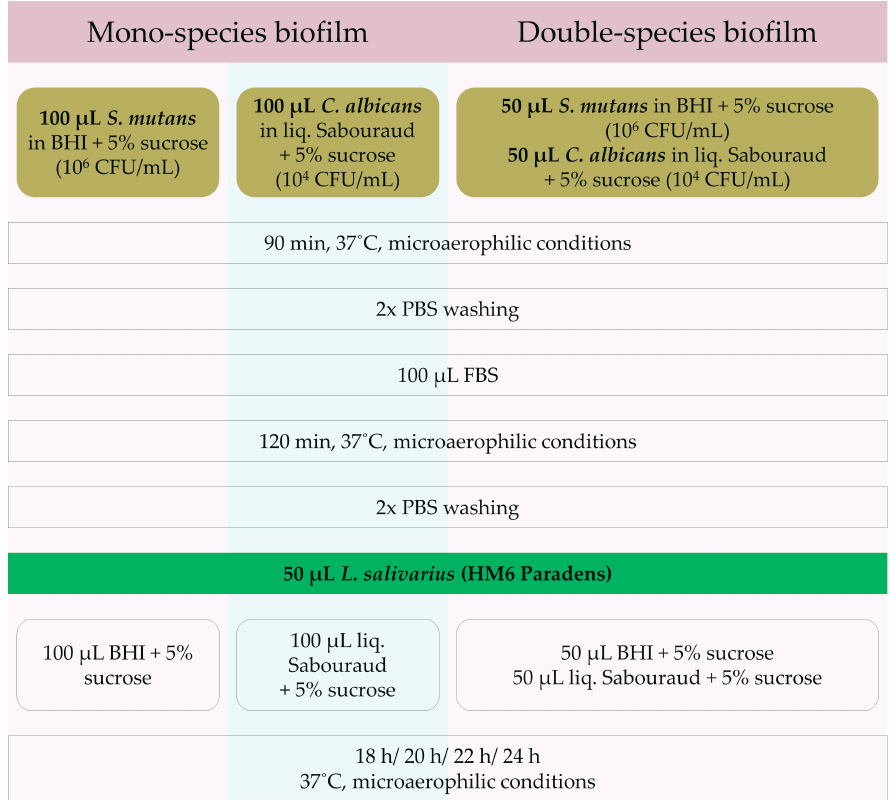
Figure 1. The protocol of biofilm generation and measurement. BHI: Brain Heart Infusion broth, CFU: colony forming units, liq: liquid, FBS: Fetal Bovine Serum, PBS: phosphate-buffered saline.